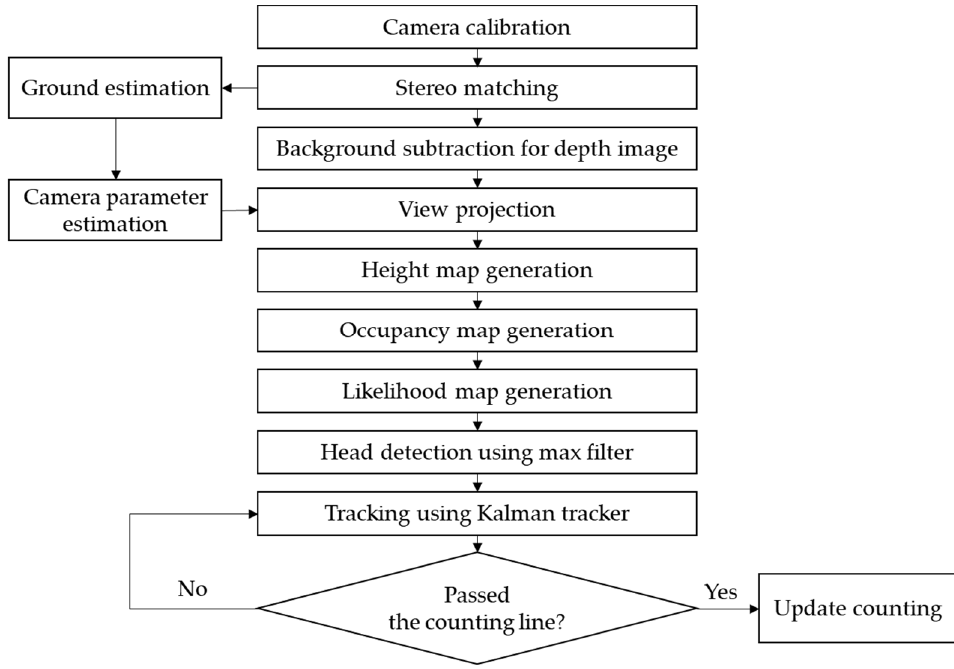
Figure 2. Flowchart of the proposed method.